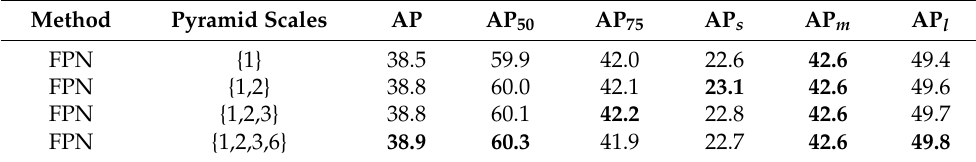
Table 3. Impacts of different pyramid scales on MS-COCO 2017 val .